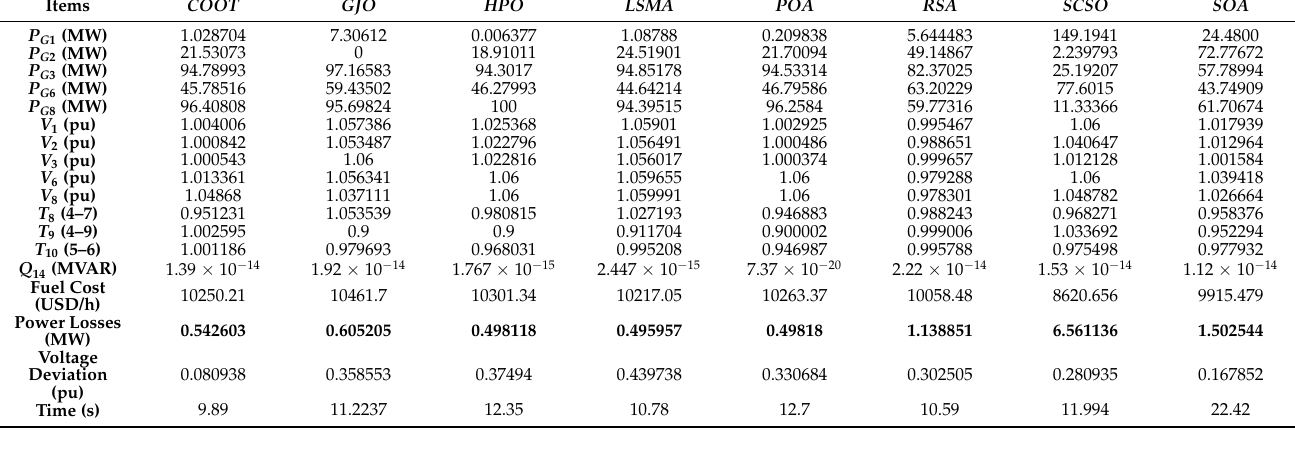
Table 3. Optimal control variables for the IEEE-14 bus test system for minimizing real power loss.